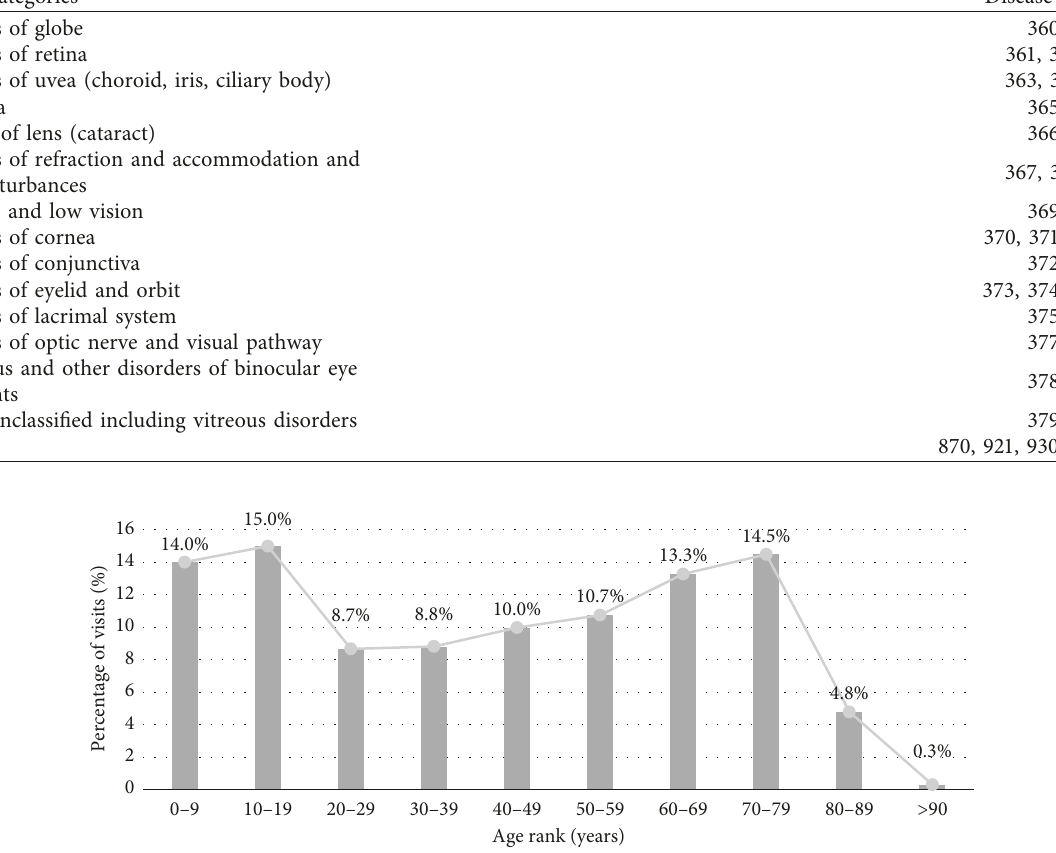
Figure 1: Distribution of eye care service visits among age ranks. Table 2: Distribution of ICD-9-CM codes according to disease